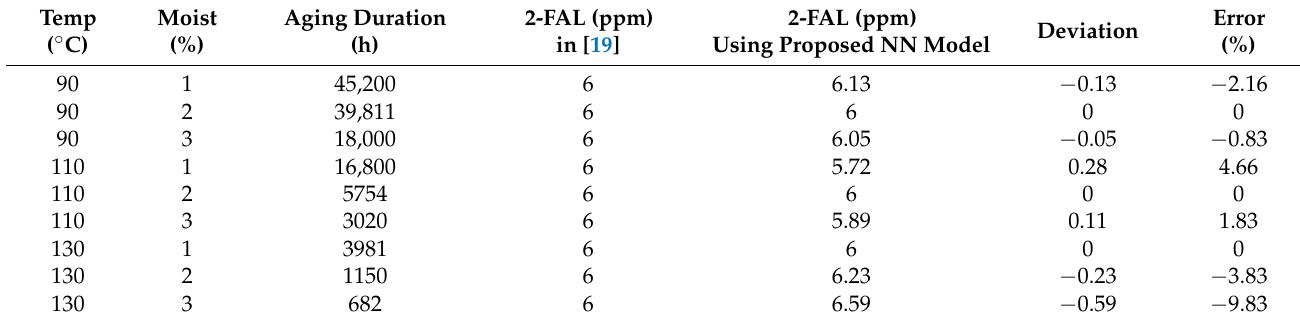
Table 3. Comparison of estimated life using neural network by treating 2-FAL as a failure index.